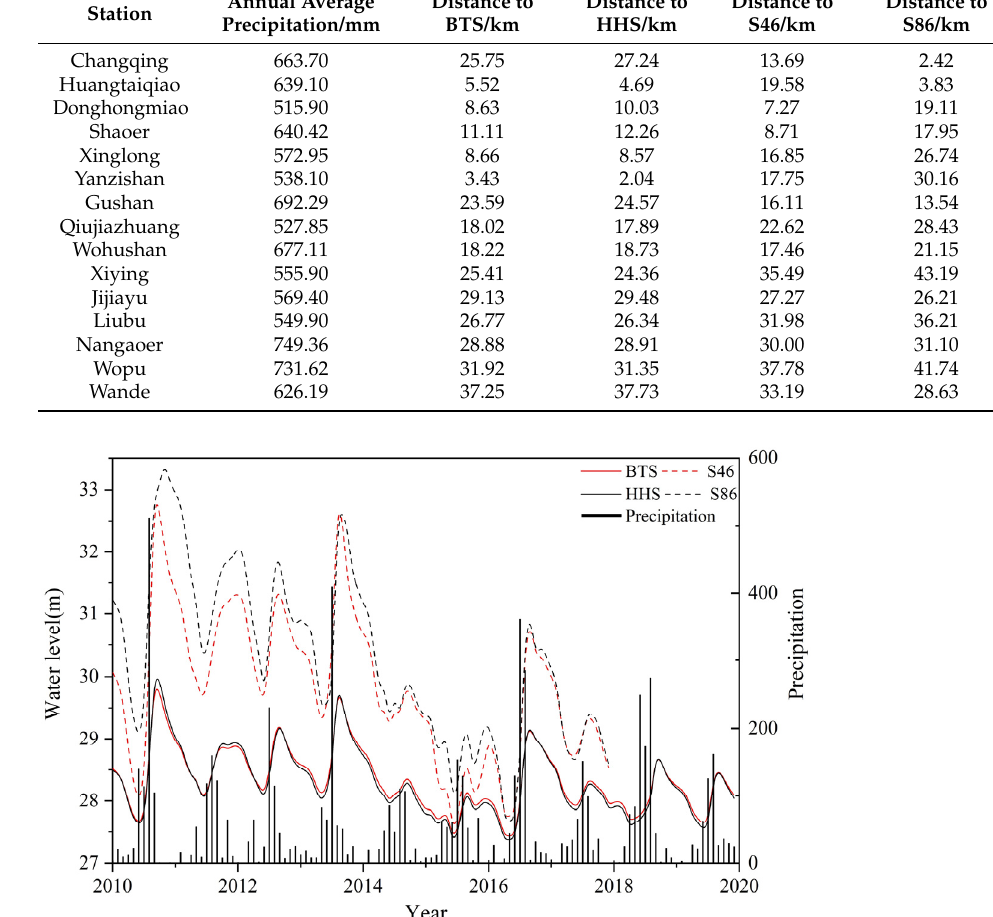
Figure 3. Plots of monthly precipitation, spring water level and groundwater level.